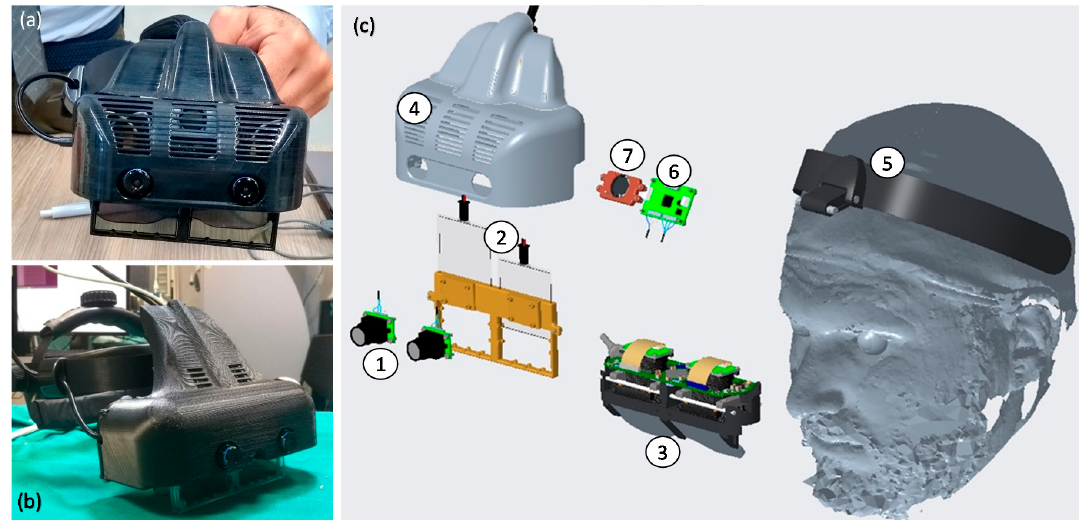
Figure 1. Photos of the assembled Video and Optical See-Through Augmented Reality Surgical System (VOSTARS) headset used for the phantom tests ( a , b ), and its exploded view ( c ): ( 1 ) pair of stereo Red-Green-Blue (RGB) cameras for optical tracking and for video-see-through (VST) augmented reality (AR) visualization; ( 2 ) pair of optical shutters (OS) for optical see-through (OST) / VST switching; ( 3 ) see-through microdisplays of the OST Triviso visor; ( 4 ) plastic cover that holds all the components added around the OST Treviso visor; ( 5 ) head mount; ( 6 ) electronic board for stereo synchronization of the camera frames; ( 7 ) cooling fan.